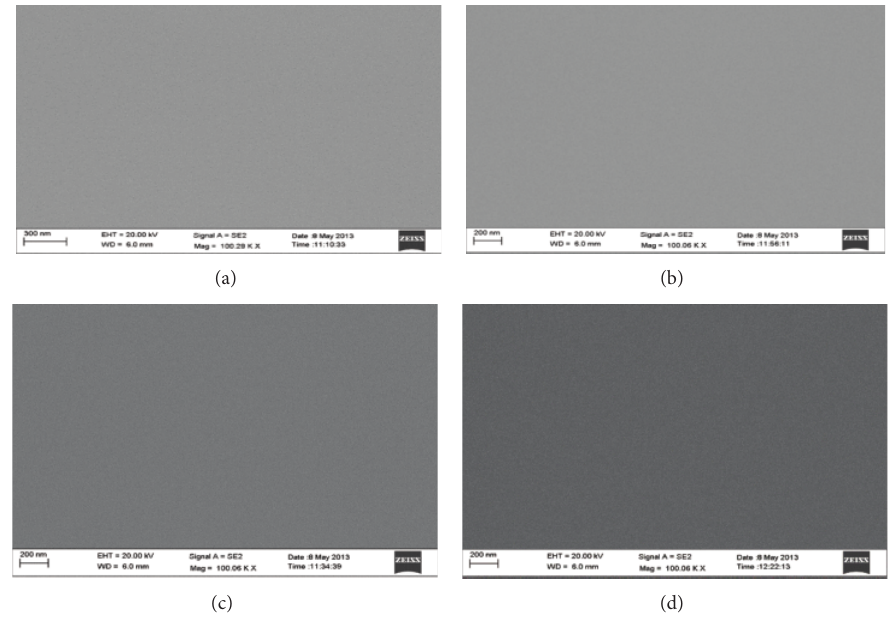
Figure 6: SEM micrographs of the oxide films developed at 0.2 and 0.7 vol% of water (a) and (b) 5.5 mA/cm 2 ; ((c) and (d)) 8 mA/cm 2 current densities in potentiodynamic